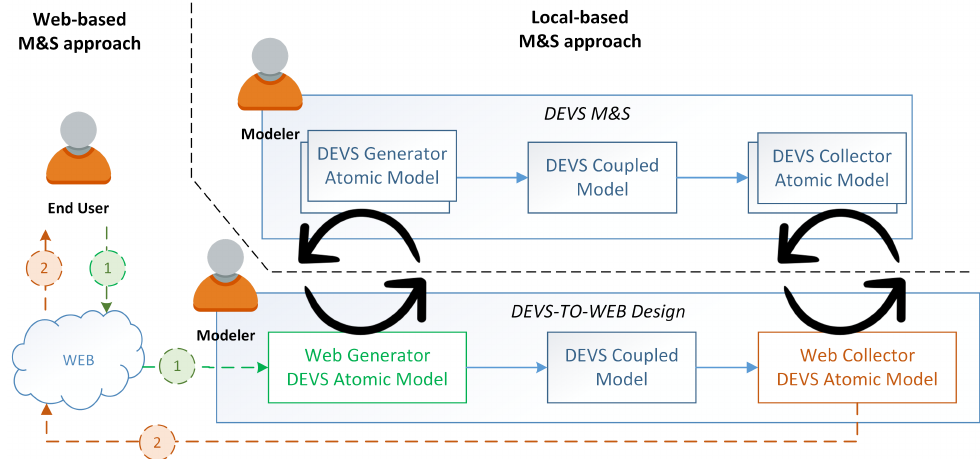
Figure 6. DEVS model-building methodology using DEVS-TO-WEB Decorator involving the DEVS Web Generator and Web Collector models introduced to enable real-time, bidirectional communication. In the web-based M&S approach, DEVS Generators (resp. Collectors) are replaced by a Web Generator (resp. Collector) DEVS atomic model involved in the local-based M&S